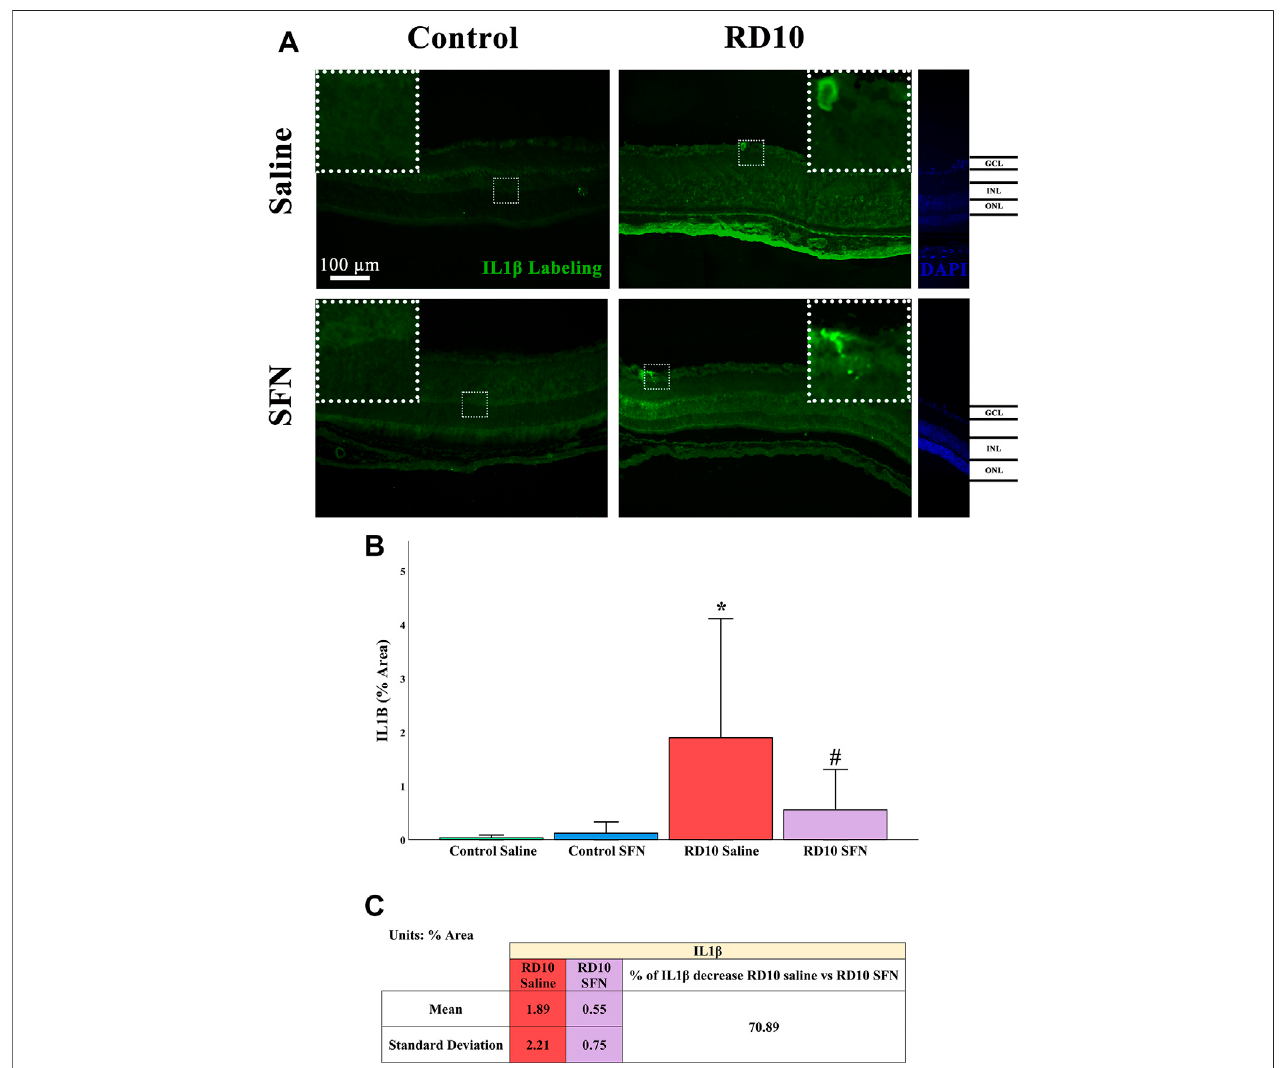
FIGURE7| IL1 β expressionassessment. (A) NerveregionimagesofIL1 β immuno fl uorescenceofthedifferentgroupsintheexperiment;whitearrowspointoutthe positivemark. (B) IL-1 β quanti fi cation expressed as areapercentage. *DifferencesbetweenControlSaline vs. RD10 Saline ( p -value < 0.05). #Differences between RD10 Saline vs. RD10 SFN ( p -value < 0.05). (C) Effect of SFN on RD10 mice IL1 β mark expressed by the mean, and standard deviation of the RD10 groups, and percentage increase in RD10 SFN vs. RD10 Saline.